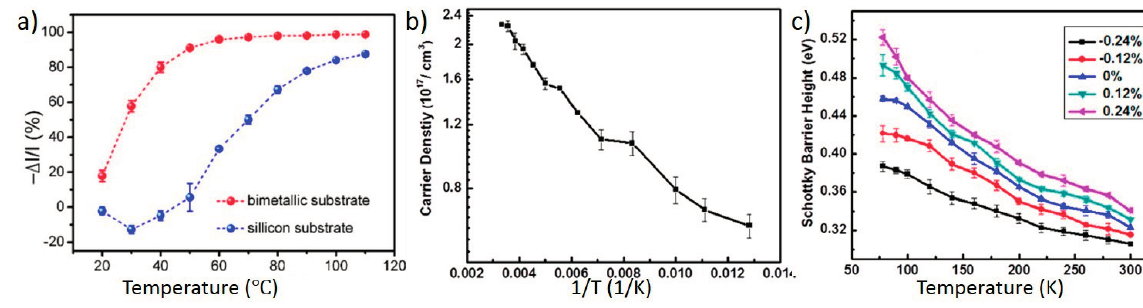
Figure 12. Direct effect of temperature on material properties of piezotronic devices. ( a ) Normalized current change at different temperatures, from two devices fabricated by Xue et al . The red curve is from an original piezotronic temperature sensor with a bimetal substrate. The blue curve is from a contrast device with a silicon substrate. Reprinted with permission from [90] (Copyright 2014, American Chemical Society); ( b ) Relationship between carrier density and inverse temperature in a piezotronic device fabricated by Hu et al .; ( c ) Change of the effective Schottky barrier height at one contact as the temperature decreased, at different strain levels. Reprinted with permission from [91] (Copyright 2013, American Chemical